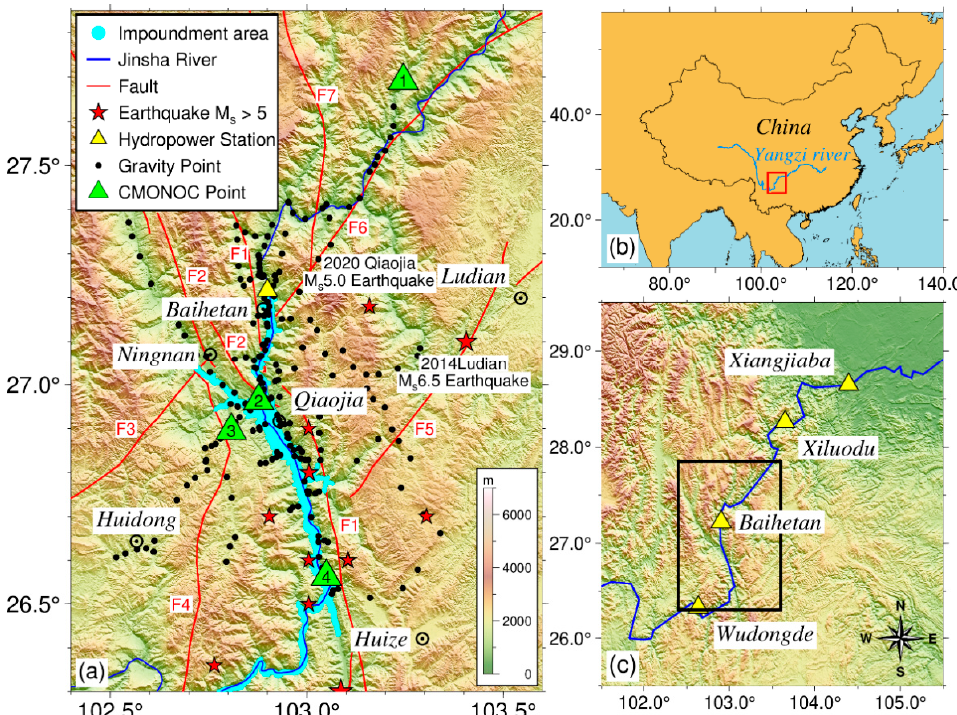
Figure 1. Tectonic and location map of the gravity stations around Baihetan reservoir. ( a ) Locations of our new gravity stations (black dots). Green triangles give the gravity stations that belong to the nationwide network Crustal Movement Observation Network of China (CMONOC). Red stars indicate earthquakes (Ms > 5). Yellow triangle represents the Baihetan hydropower station. Blue area shows the reservoir. Red lines are faults. F1: Xiaojiang fault, F2: Zemuhe fault, F3: Ninghui fault, F4: Puduhe fault, F5: Zhaotong–Ludian fault, F6: Lianfeng fault, F7: Ganluo–Zhuhe fault. Colors represent terrain of the study area. ( b ) Location of Figure 1c in China. ( c ) Location of Wudongde, Baihetan, Xiluodu and Xiangjiaba hydropower stations (Yellow triangles). Blue line indicates the Jinsha River. Black box shows the location of Figure 1a.